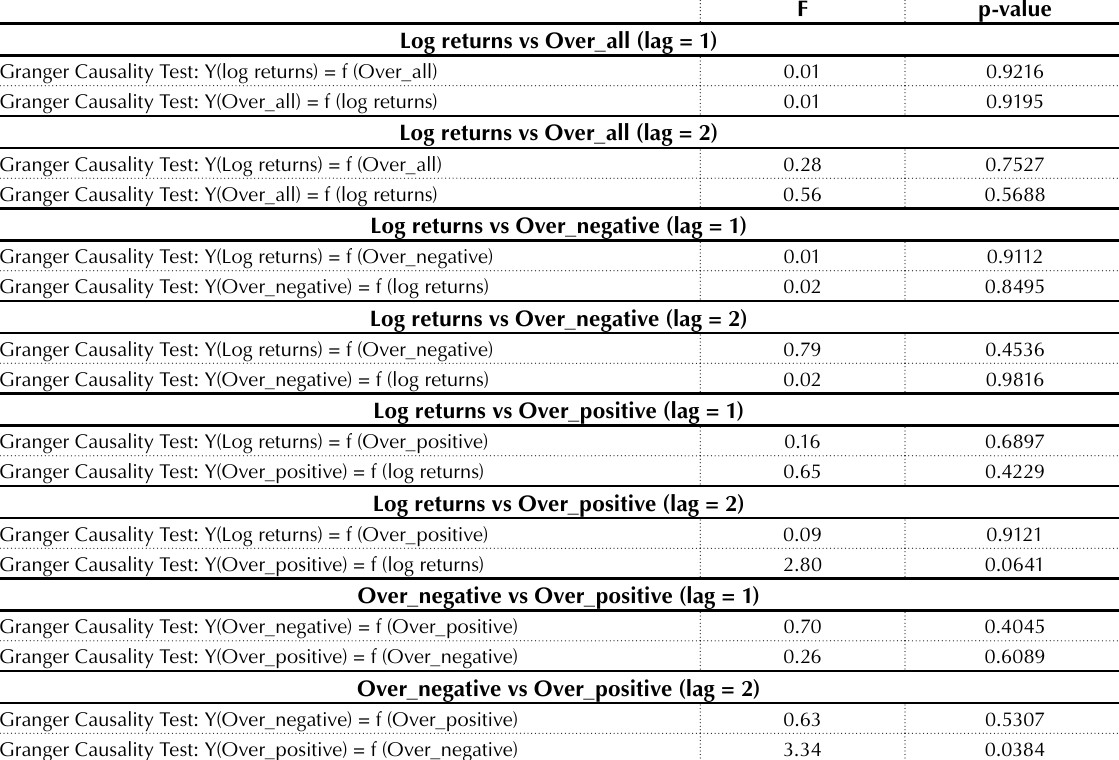
Table 5. Granger Causality Test: Log returns vs overreactions frequency F p-value Log returns vs Over_all (lag = 1)